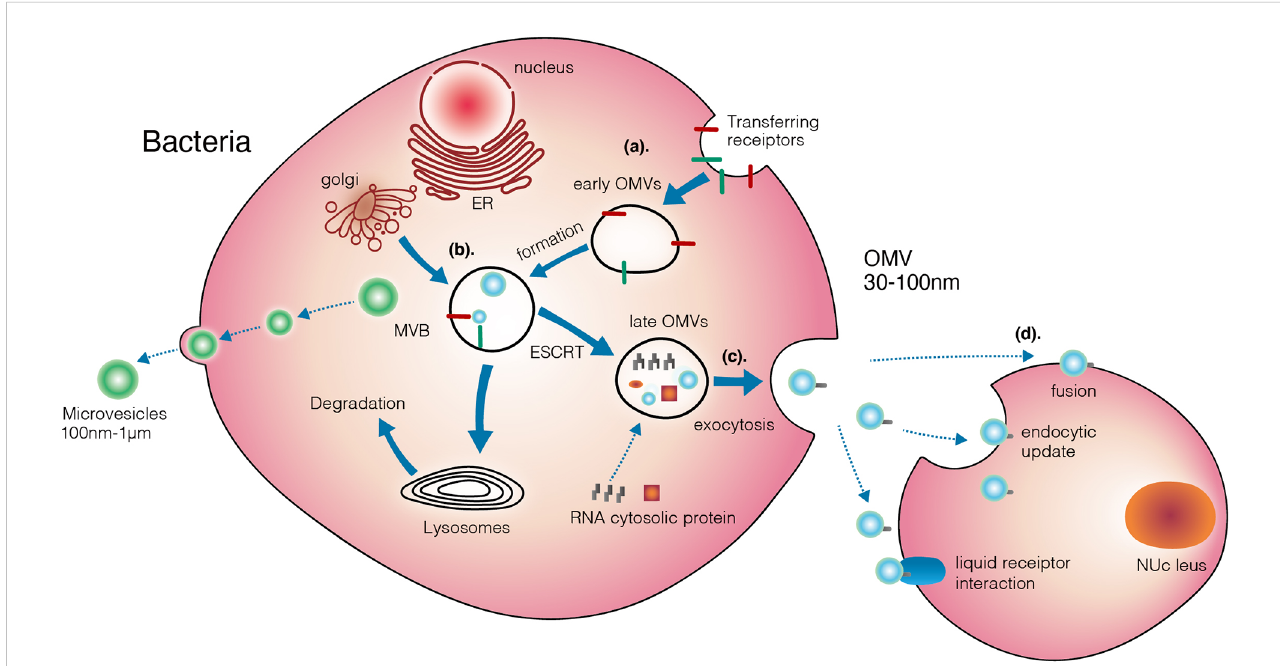
FIGURE 4 Three different mechanisms that mediating transferring of OMVs from bacteria to target